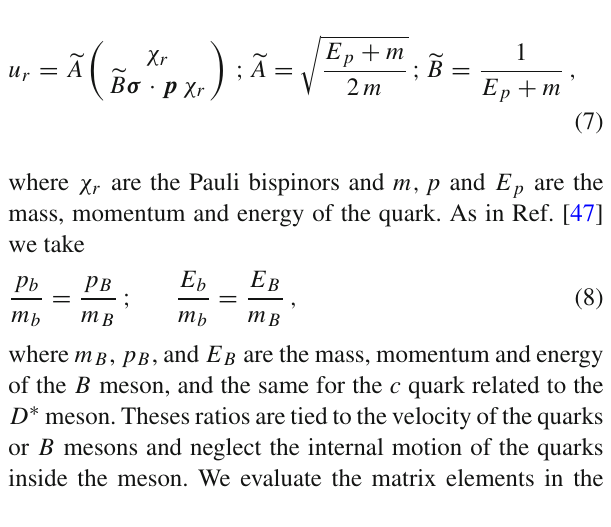
Fig. 1 for B − → D ∗ 0 ¯ ν l l